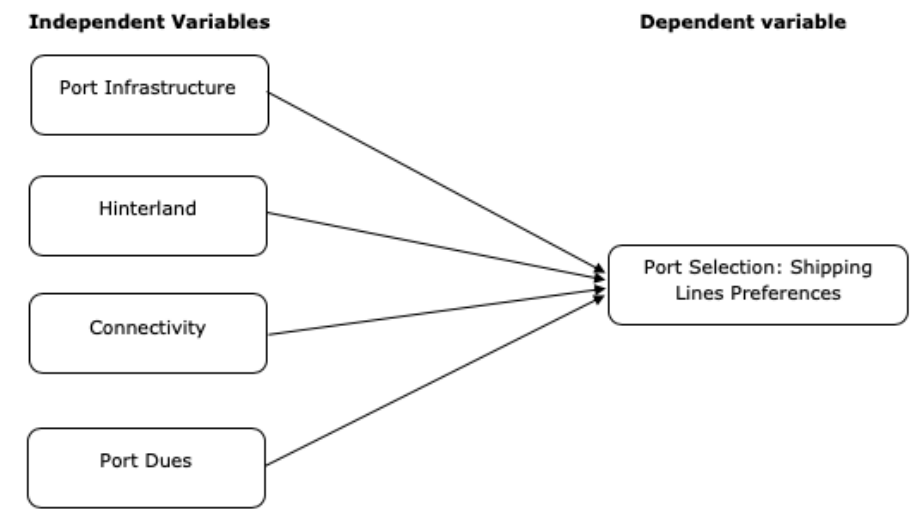
Figure 1. Conceptual